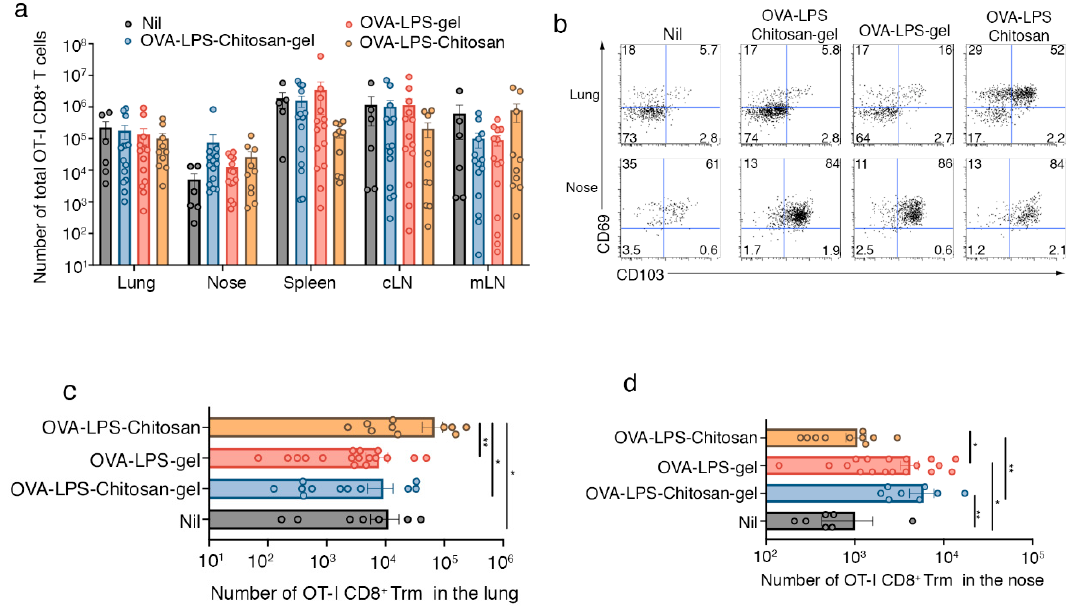
Figure 2. Intranasal immunization with a chitosan-hydrogel vaccine results in the development of nasal Trm. ( a – d ) Mice were seeded with 5 × 10 6 in-vitro-activated CD45.1 + CD8 + OT-I T cells and then intranasally immunized with either saline (nil), OVA-LPS-chitosan, OVA-LPS-chitosan gel or OVA-LPS gel and, 30 days later, the ( a ) absolute number of total OT-I cells in the lung, nose, spleen, cLN and mLN was measured. ( b ) Representative flow cytometry profiles gated on OT-I.CD8 + T cells in the nose and lung show the expression levels of CD103 and CD69. ( c , d ) The absolute number of tissue resident (CD103 + CD69 + ) OT-I in the ( c ) lung and ( d ) nose was determined. Data pooled from three independent experiments. Symbols represent individual mice, bars represent the mean + SEM ( n = 7–18 mice per group; one-way ANOVA, Tukey’s multiple comparison). * p < 0.5, ** p < 0.01